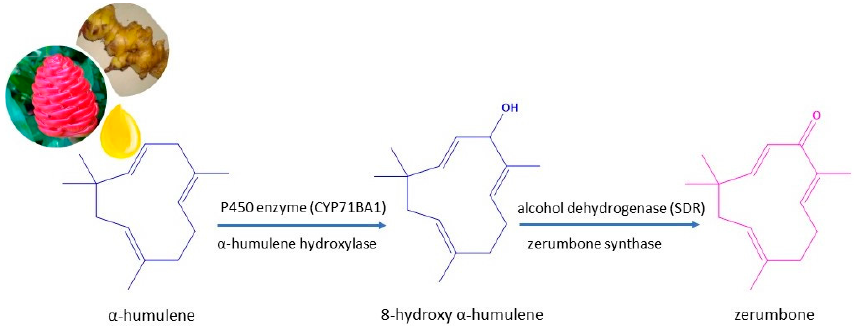
Figure 1. Biosynthetic route of zerumbone from α -humulene catalyzed by a short-chain dehydro- genase/reductase (SDR). nase/reductase